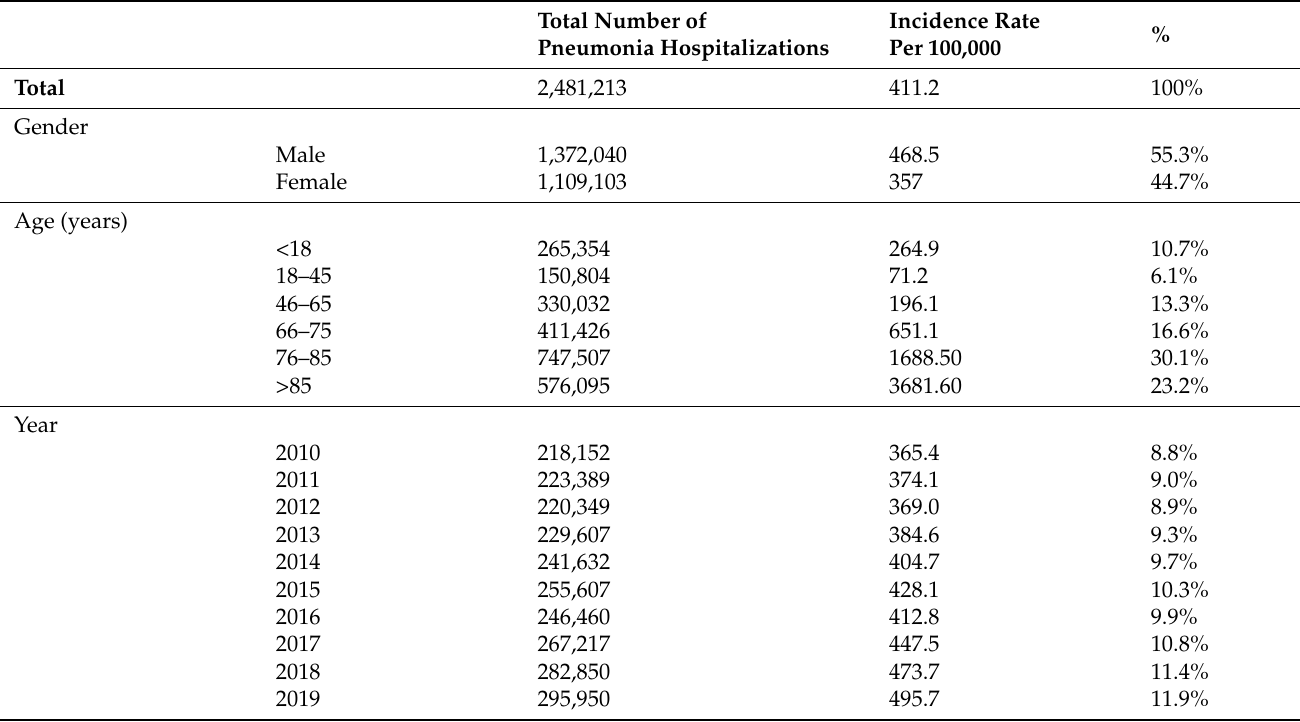
Table 1. General characteristics of hospitalizations for pneumonia in Italy from 2010 to 2019.